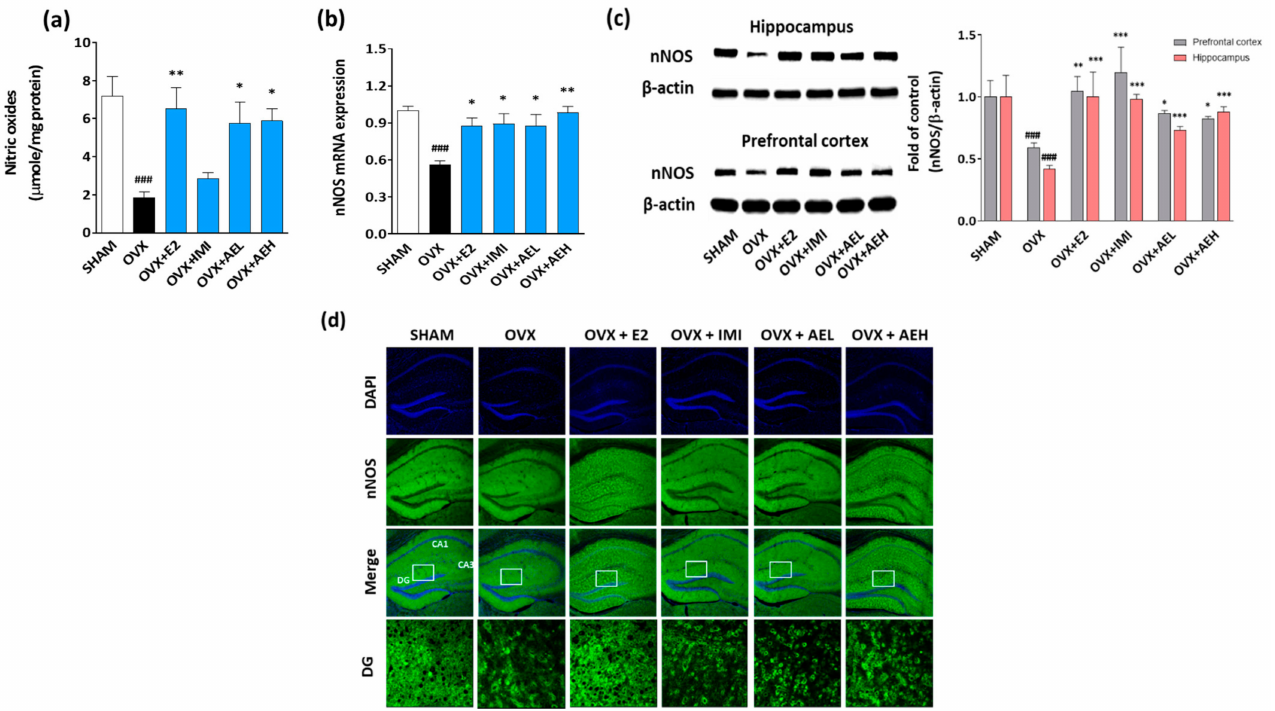
Figure 3. AE upregulates the hippocampal NO-mediated signaling network in estrogen deficiency-induced depressive mice. OVX mice were exposed to estrogen deficiency for 20 weeks with or without AE (100 or 300 mg/kg). ( a ) NO content in the brain tissue of OVX mice. ( b ) nNOS mRNA expression levels in the hippocampus of OVX mice. ( c ) Immunoblots showing nNOS protein levels in the hippocampus and prefrontal cortex of OVX mice. ( d ) Representative images of nNOS+ neurons from the hippocampus and DG areas. Nuclei were counterstained with DAPI (blue) and nNOS staining of hippocampus (green) X100. Results are presented as mean ± SD. ### p < 0.001 vs. SHAM group; * p < 0.05, ** p < 0.01, *** p < 0.001 vs. OVX group.